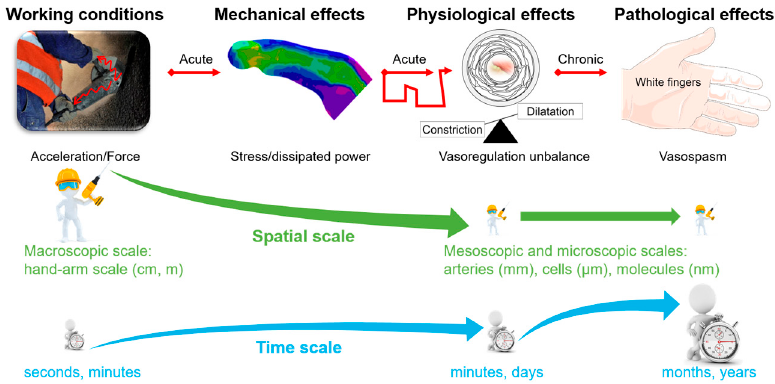
Figure 1. Simplified overall view of the development of vibration-induced Raynaud’s syndrome: from working conditions to pathological consequences, passing via mechanical and physiological effects.